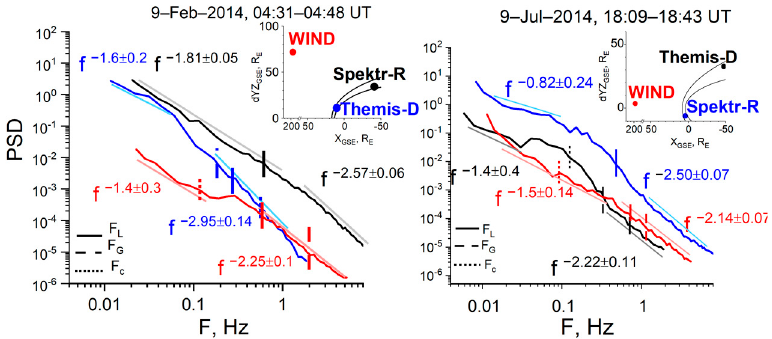
Figure 3. Comparison of the normalized spectra in the SW (red line), in the dayside (blue line) and flank (black line) MSH for the undisturbed SW flow of type Slow for the cases on 9 February 2014 ( left ) and on 9 July 2014 ( right ).